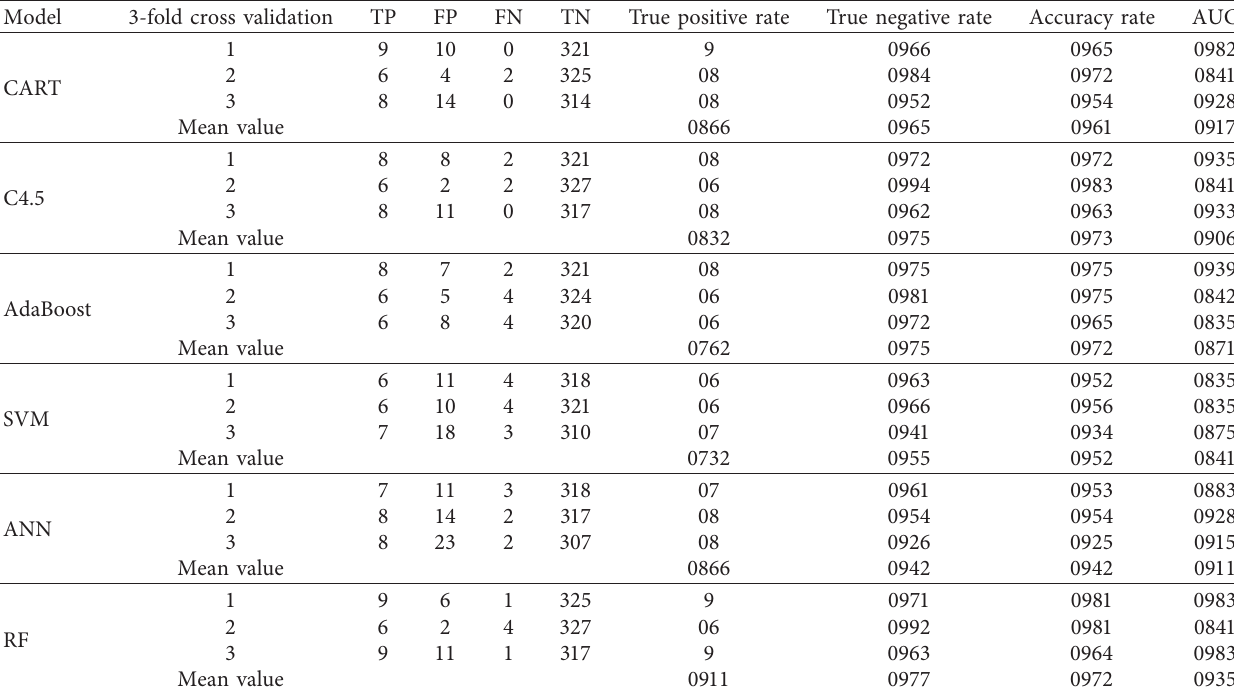
Table 5: Results of 3-fold cross